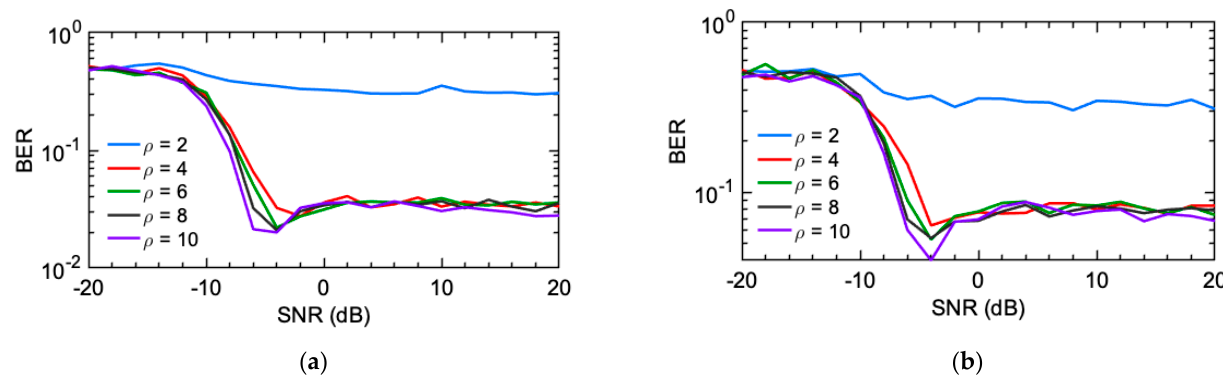
, 𝑁 (cid:3021)(cid:3051) = 4,𝑎𝑛𝑑 𝛾 = 1.3) : ( a ) 𝑋 (cid:2871)(cid:3031)(cid:3003) slow-fading. ( b ) 𝑋 (cid:2871)(cid:3031)(cid:3003) slow-fading and 1.5 dB of , N Tx = 4, and γ = 1.3 ) : ( a ) X 3 dB slow-fading. ( b ) X 3 dB slow-fading and 1.5 dB of (cid:2870) 2